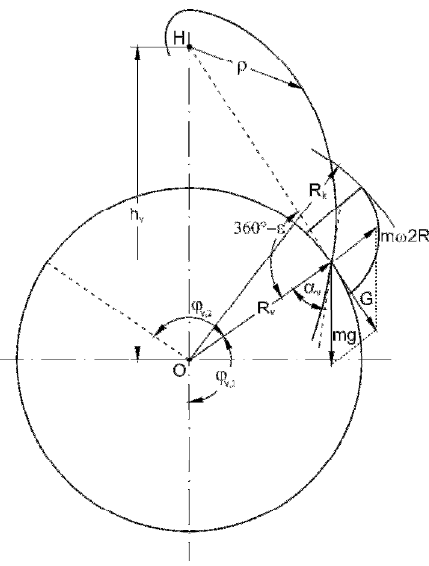
Fig. 3. Scheme of emptying of bucket (Vladimirov et al. 1968)